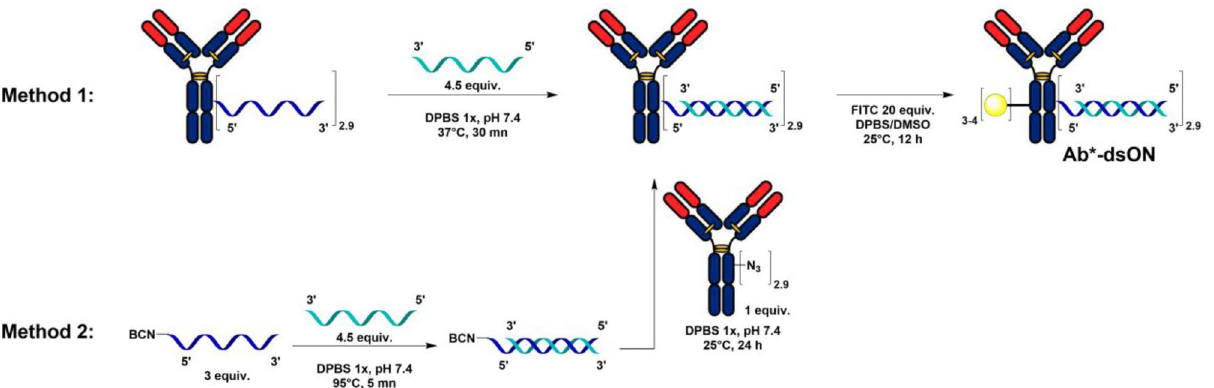
Figure 5. General scheme for the synthesis and labelling of Ab*-dsON